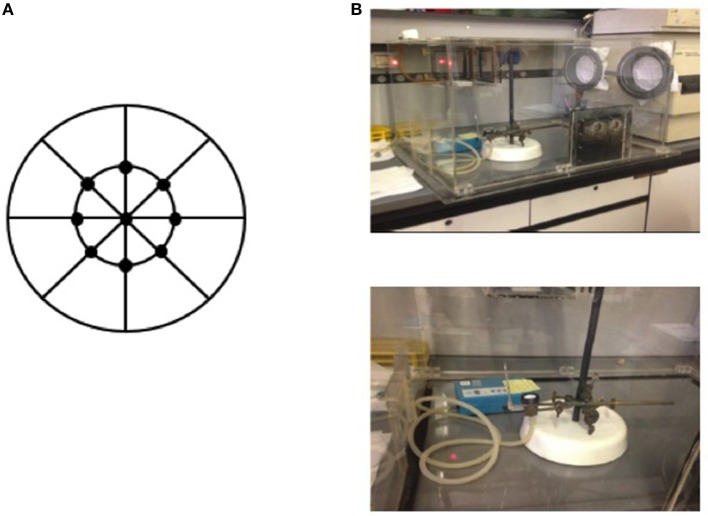
Sampling procedure of HU on a filter by acquiring nine spectra for each membrane (A) in a preserved glove box (B).